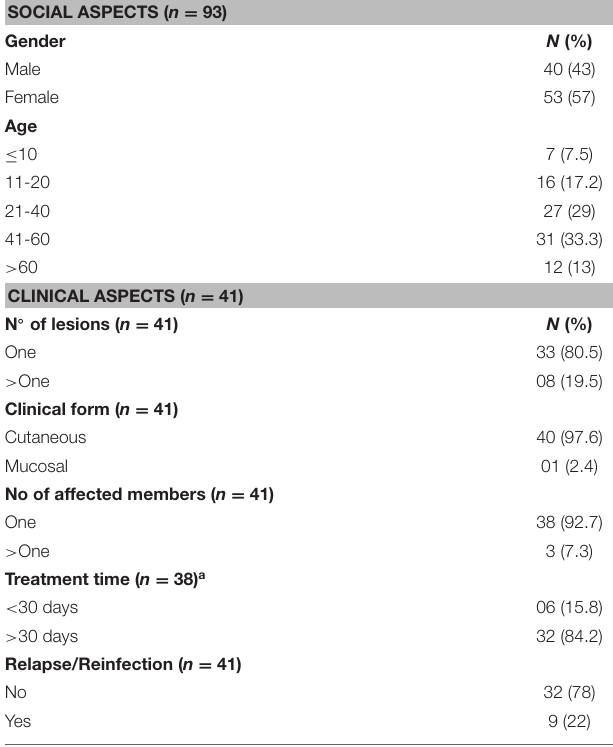
TABLE 1 | Social aspects and clinical characteristics of individuals with a previous report of American Tegumentary Leishmaniasis (ATL) living in the rural community of Brejo do Amparo, Minas Gerais,